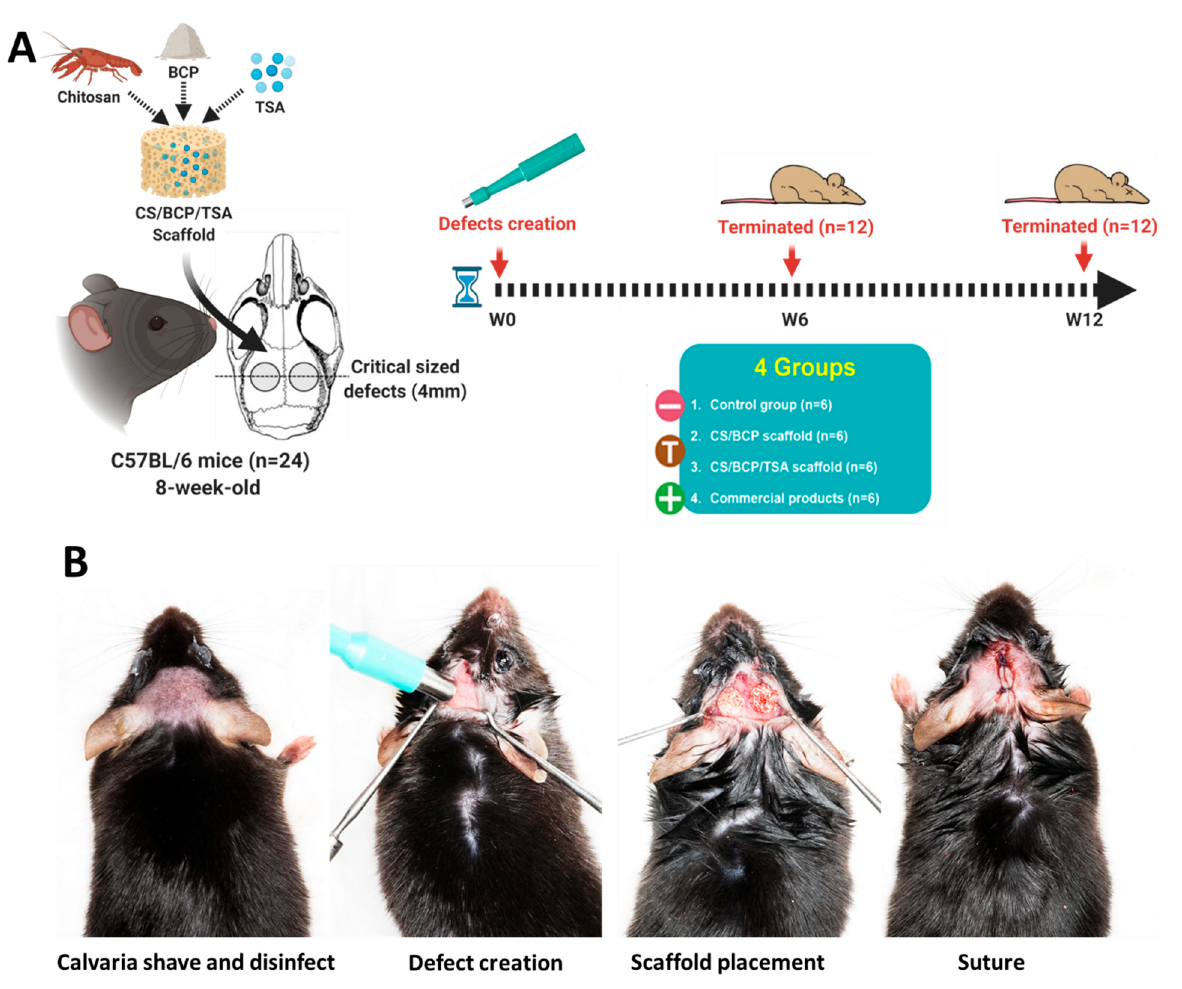
Figure 6. Mouse calvaria defect model. ( A ) A schematic illustration of animal experiments. ( B ) Sur- gical steps: Calvaria shave and disinfect, defect created by biopsy punch, scaffold placement, and wound closure by suture.